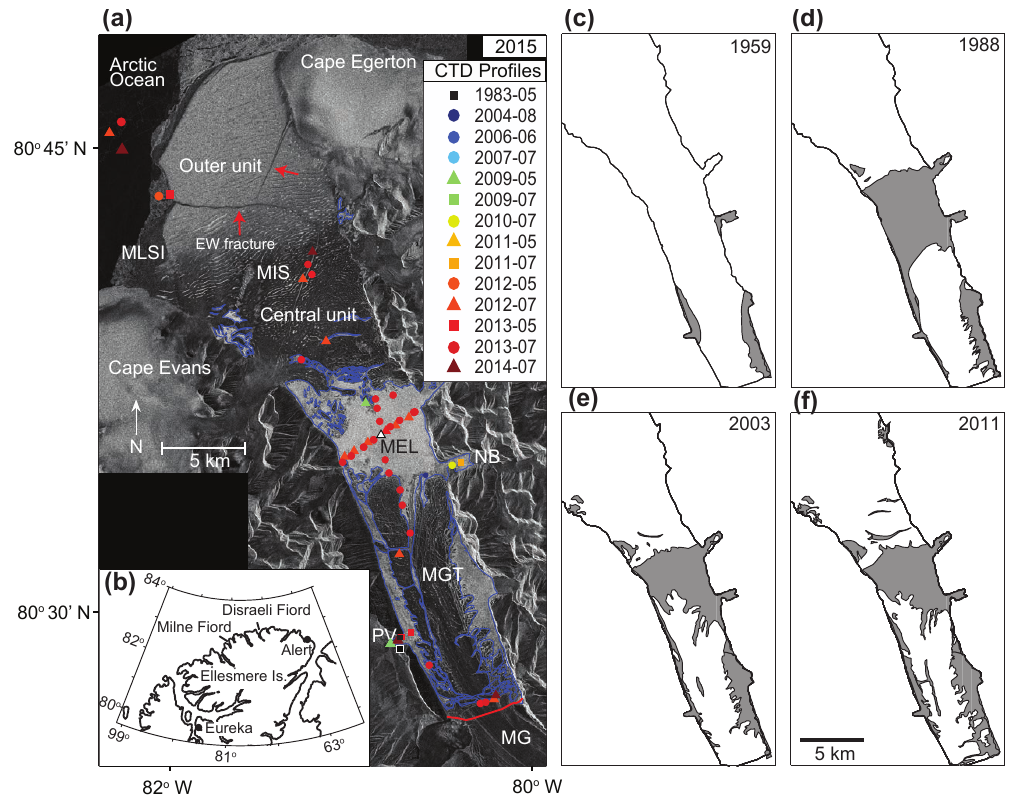
Figure 2. Map of Milne Fiord study area. (a) RADARSAT-2 image mosaic of Milne Fiord showing the extent of the Milne Fiord epishelf lake (MEL) in 2015, corresponding to the region of high backscatter (light grey) outlined in blue. The locations of CTD profiles collected during each field campaign are shown. The central and outer units of the Milne Ice Shelf (MIS), as well as two re-healed fractures (red arrows), are indicated, as well as the Milne Glacier (MG), grounding line (red line), Milne Glacier tongue (MGT), multiyear landfast sea ice (MLSI), the met station (white and black square), mooring (white and black triangle), and two small inlets unofficially named Purple Valley Bay (PV) and Neige Bay (NB). (b) Regional map of Ellesmere Island, Canada. The sequence of four panels on the right shows the increase in area of the MEL (grey) estimated from aerial and satellite imagery from (c) 1959, (d) 1988, (e) 2003, and (f) 2011, based on data from Mueller et al. (2017a). The coastline of Milne Fiord is outlined in black. White areas inside the coastline are glacier or ice